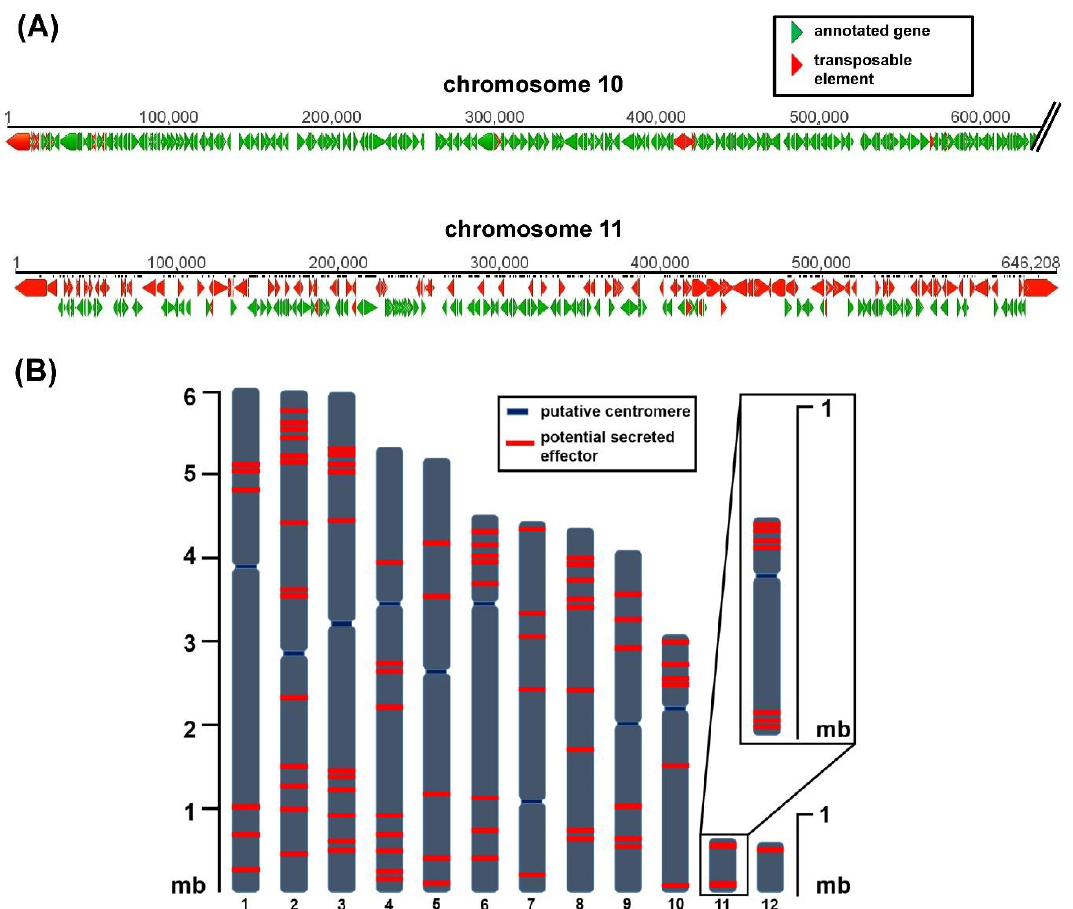
Figure 1. Representation of the genome structure and e ff ector candidate distribution on chromosomes of C. higginsianum ( A ) Comparison of sequences from core chromosome 10 and mini chromosome 11. Red bars display transposable elements, green bars display annotated genes. The first 600 kb of chromosome 10 are shown here. Software Geneious 5.5.9 ( B ) Distribution of e ff ector candidate genes (red bars) on chromosomes of C. higginsianum . n = 87, annotated as C. higginsianum e ff ector candidate genes (ChECs) in [20].